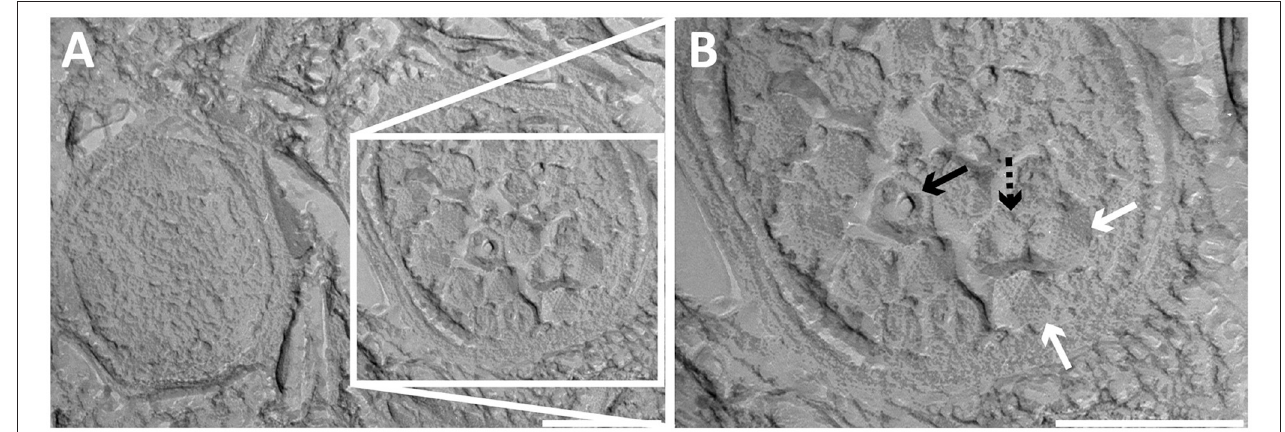
FIGURE 3 | Transmission electron micrographs of high-pressure frozen and freeze-etched Methylomirabilis cells taken from a bioreactor enrichment culture. (A) Cross-section of a non-infected (left) and infected (right) Methylomirabilis cell. (B) The bacteriophages (white arrows) contain a proteinaceous capsid. The capsid is made of triangular faces built by capsomeres. Concave (dashed black arrow) and convex (black arrow) printing of the internal core is visible in two of the viral particles. Scale bars; 200